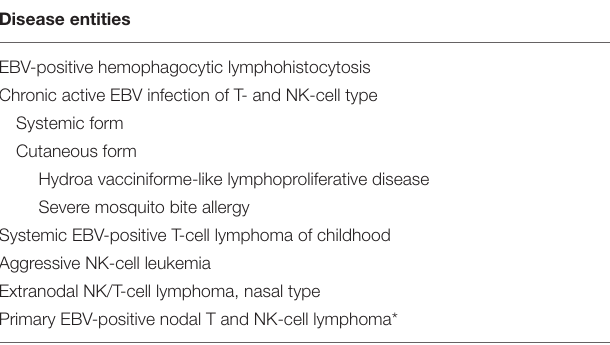
TABLE 1 | EBV-associated T and NK- cell lymphoproliferative diseases. Disease